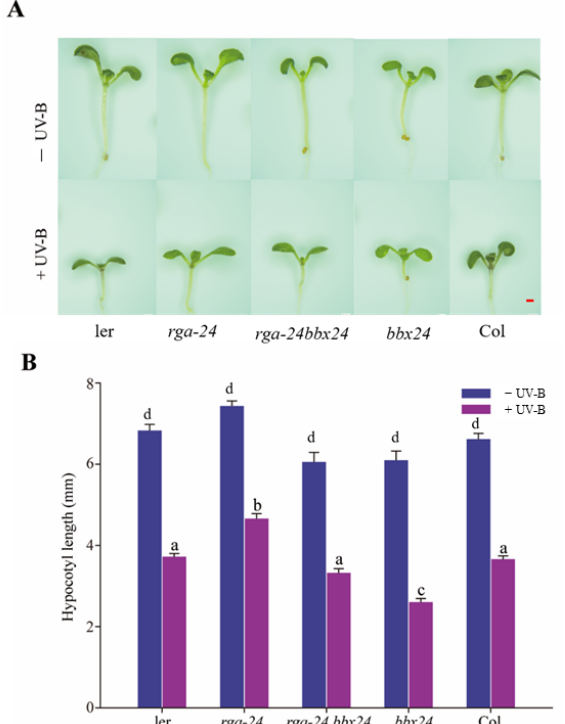
Figure 5. DELLA and BBX24 have antagonistic effects on the UV-B signal transduction pathway. ( A , B ) Hypocotyl phenotypic analysis. Seedlings of wild type ( Ler and Col-o ), rga-24 , bbx24 , and rga-24 bbx24 double mutant were grown for 8 days in the presence of UV-B radiation. Images of the representative seedlings are shown in ( A ). The hypocotyl lengths of the indicated genotypes were measured and are shown in ( B ). Bar = 1 mm. Error bars indicate SE ( n ≥ 15). The letters ‘a’ to ‘c’ indicate statistically significant differences between the hypocotyl lengths of the indicated seedlings grown in the presence of UV-B radiation, as determined by Tukey’s least significant difference test ( p < 0.05).